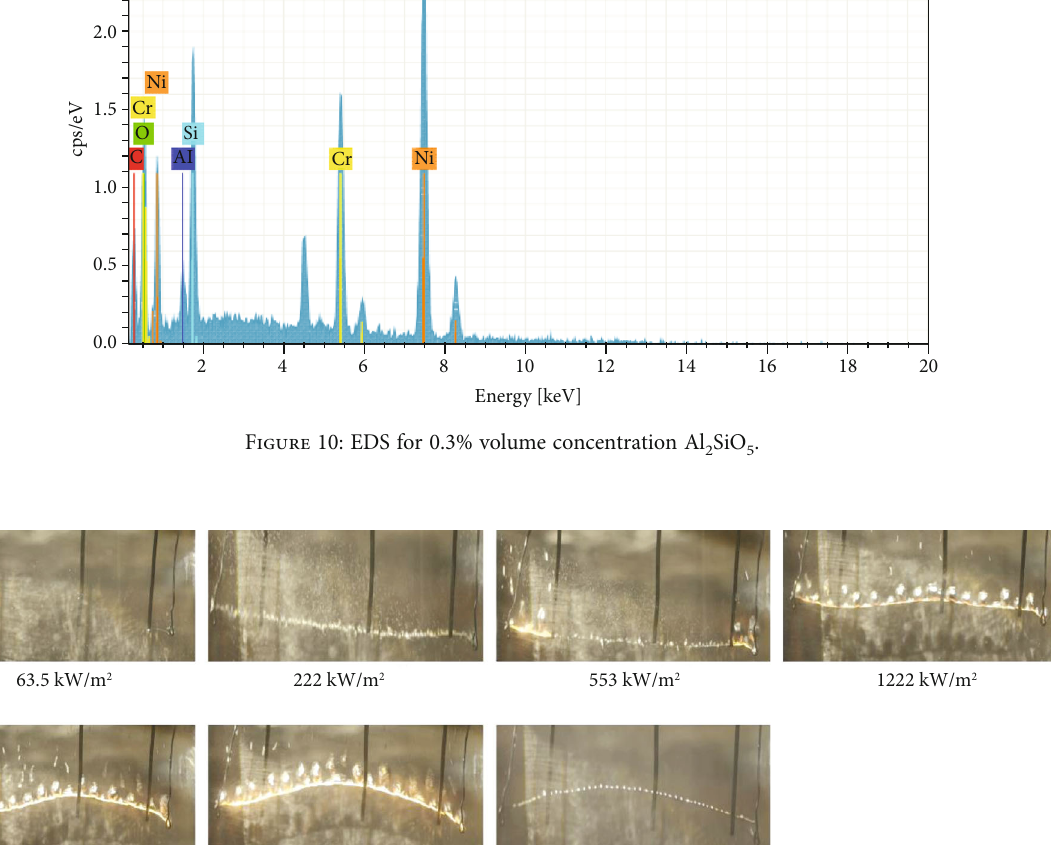
Figure 11: Bubble diameter variation with increase in heat fl ux for water.